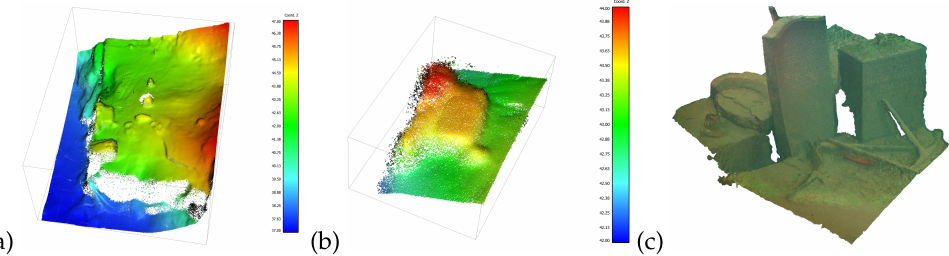
Figure 11. Comparison of ( a ) the sonar data, ( b ) a detailed view of the sonar data, and ( c ) the photogrammetric data (right) of two gravestones.